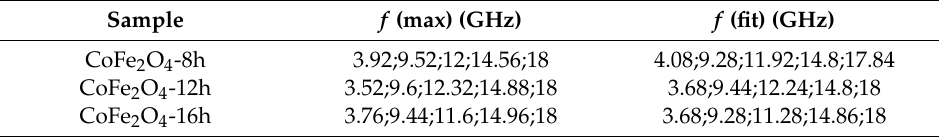
Figure 3. ( a ) Real part of the effective permittivity, ( b ) imaginary part of the effective permittivity, ( c ) the fitting curve of the imaginary part of effective permittivity, (I) 8 h; (II) 12 h; (III) 16 h; ( d ) the dielectric loss factor. Table 1. fitting parameters for the imaginary part of the effective permittivity spectrum.